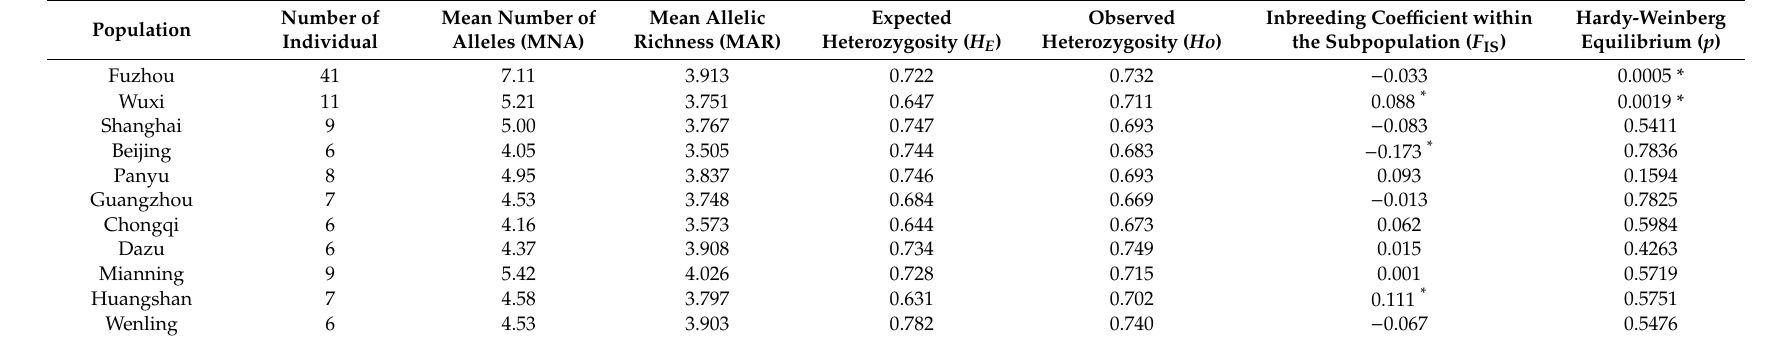
Table 5. Genetic diversity from 11 captive red panda populations. * Significant ( p < 0.05).